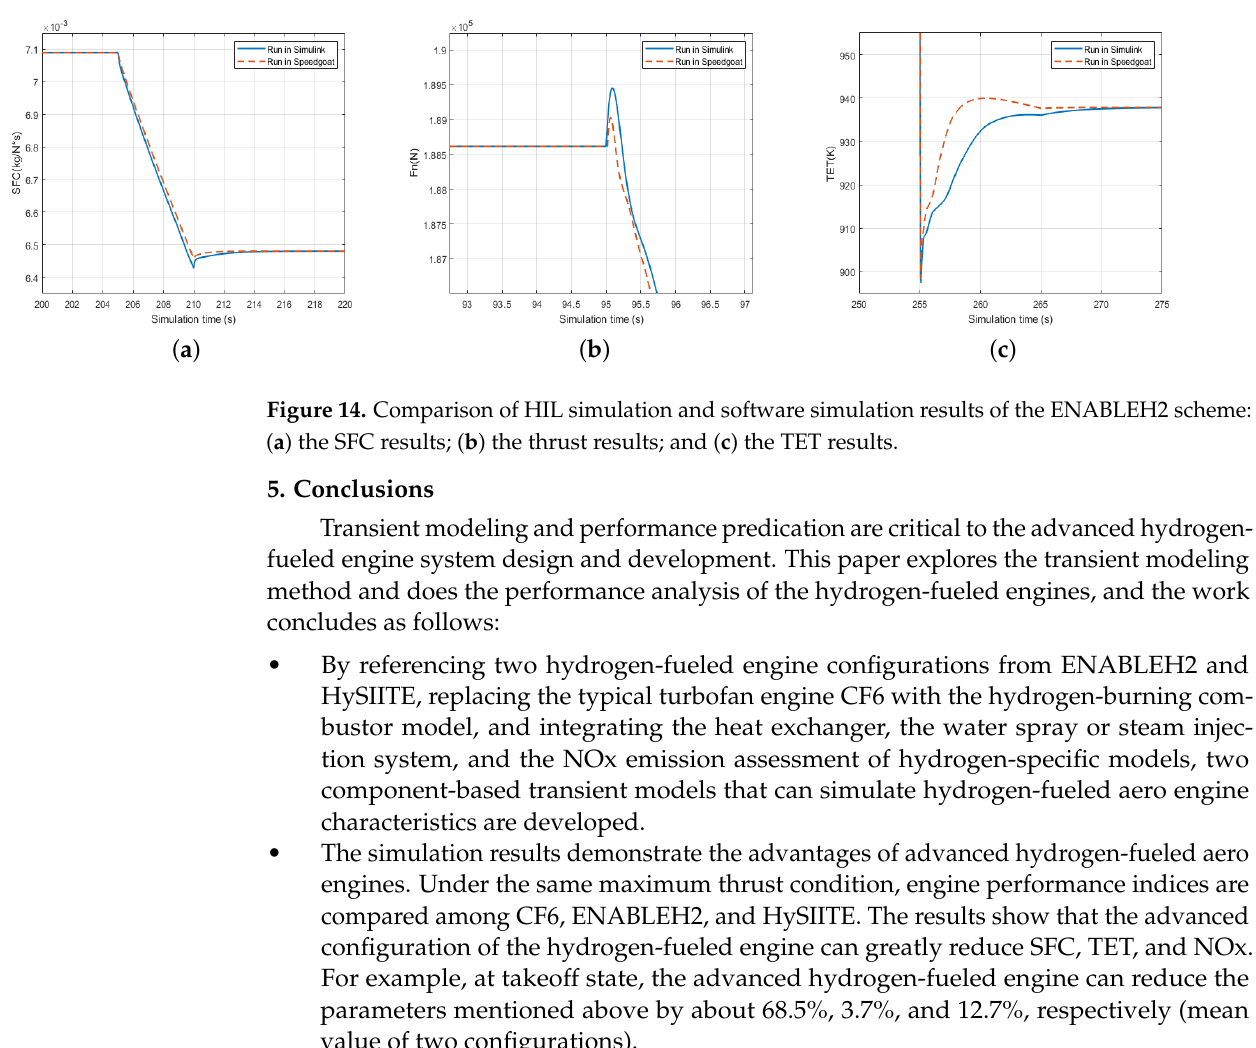
Figure 13. Comparison of HIL simulation and software simulation results of the HySIITE scheme: ( a ) the SFC results; ( b ) the thrust results; and ( c ) the TET results.